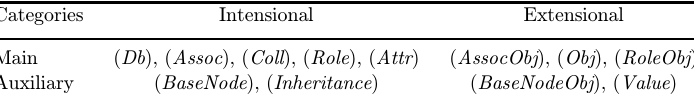
3. Diagram of classes illustrating basic relationships between crucial notions functioning in the sphere of Table 1. Complex primitives of the AODB.